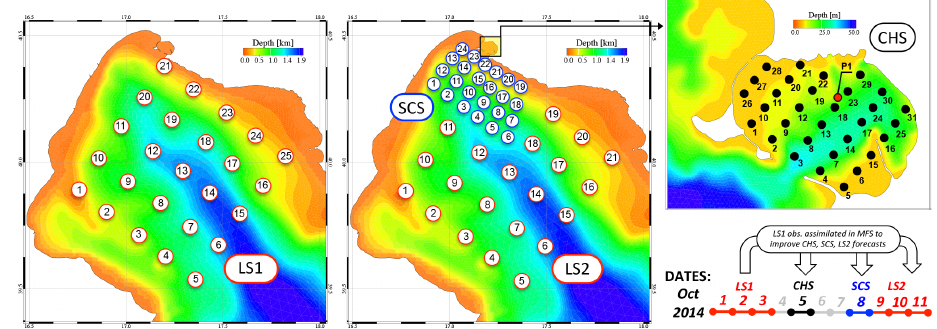
Figure 4. Sampling strategy of MREA2014 on the three scales. All the circle points refer to CTD stations. P1 refers to the fixed monitoring station in Mar Grande with CTD, ADCP and tidal measures. The MREA timeline is also reported.